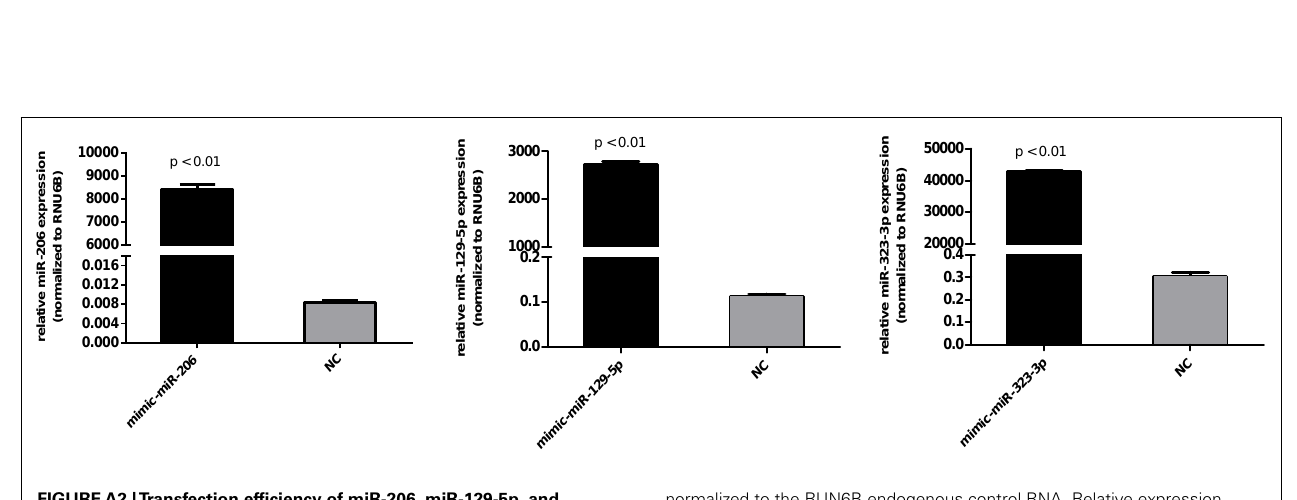
FIGUREA2 |Transfection efficiency of miR-206, miR-129-5p, and miR-323-3p in DAOY cells as evaluated by RT-qPCR . Cells transfected with the scrambled mimic were included as negative control (NC).Values were